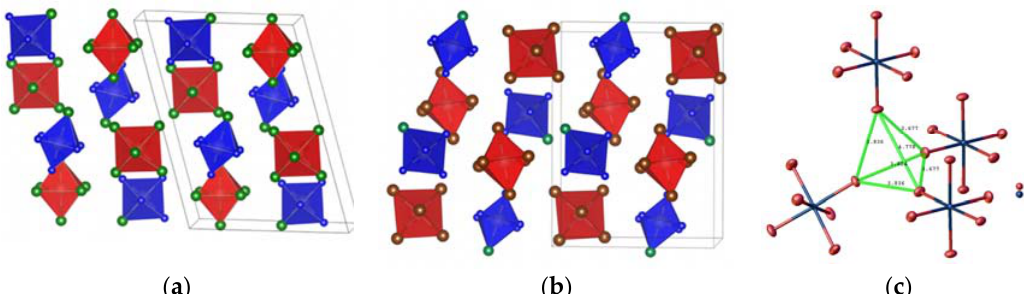
Figure 2. Crystal structure of [Rh(NH 3 ) 5 Cl][OsCl 6 ] along the monoclinic axis y ( a ) [14]; right: crystal structure of [Ir(NH 3 ) 5 Cl][PtBr 6 ] along the monoclinic axis y and ( b ) ([Rh(NH 3 ) 5 Cl] 2+ or [Ir(NH 3 ) 5 Cl] 2+ cations are shown in red, [OsCl 6 ] 2 − or [PtBr 6 ] 2 ‐ anions and N – in blue, green – Cl or Br; H atoms are omitted for clarity); short Br…Br contacts between [PtBr 6 ] 2 ‐ anions in the [Ir(NH 3 ) 5 Cl][PtBr 6 ] crystal structure ( c ).